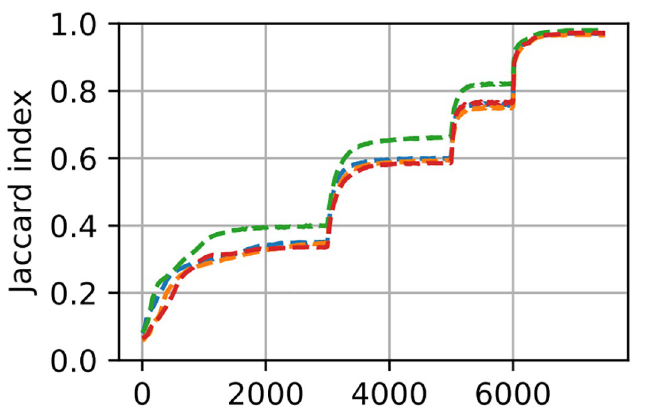
Fig 5. Accuracy, in terms of the Jaccard index, as a function of the number of iterations for the first four retinal image registrations (shown in different colours) with INSPIRE. The points of steep increase in accuracy correspond to the changes of coarseness-level allowing more freedom to optimize to local deformations. Especially in the later levels, most of the progress happens in rather few iterations.